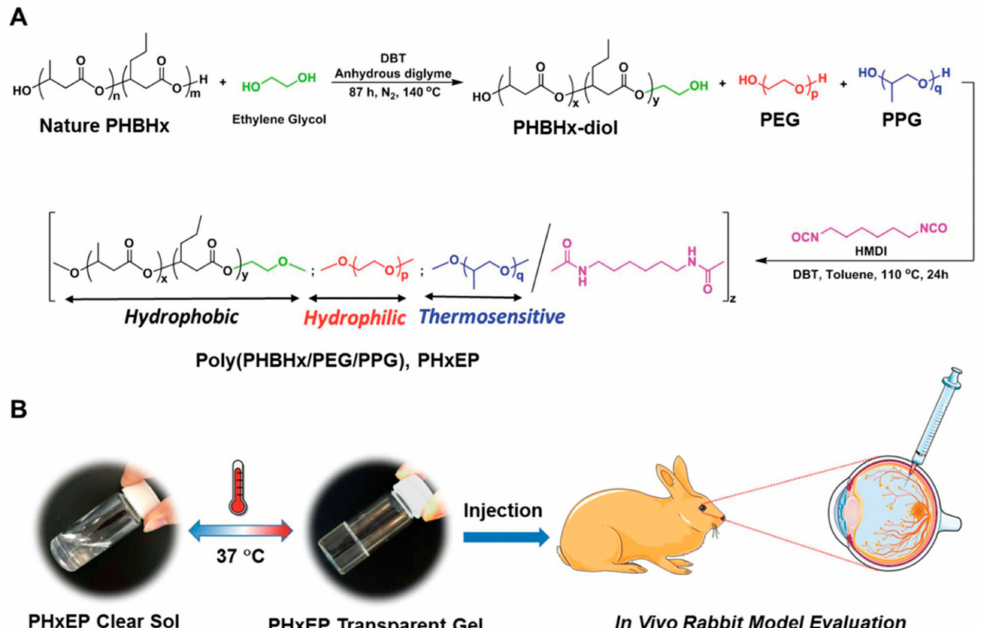
Figure 4. ( A ). Schematic illustration of the synthetic route of poly(PHBHx/PEG/PPG urethane); ( B ). hydrophobic PHBHx content is varied within the hydrogel, and that can change the gel properties from cloudy to transparent at 37 ◦ C. The gels are then tested for in vivo eye application. Image adapted from Loh et al., (2019) and reprinted with permision from Royal society of